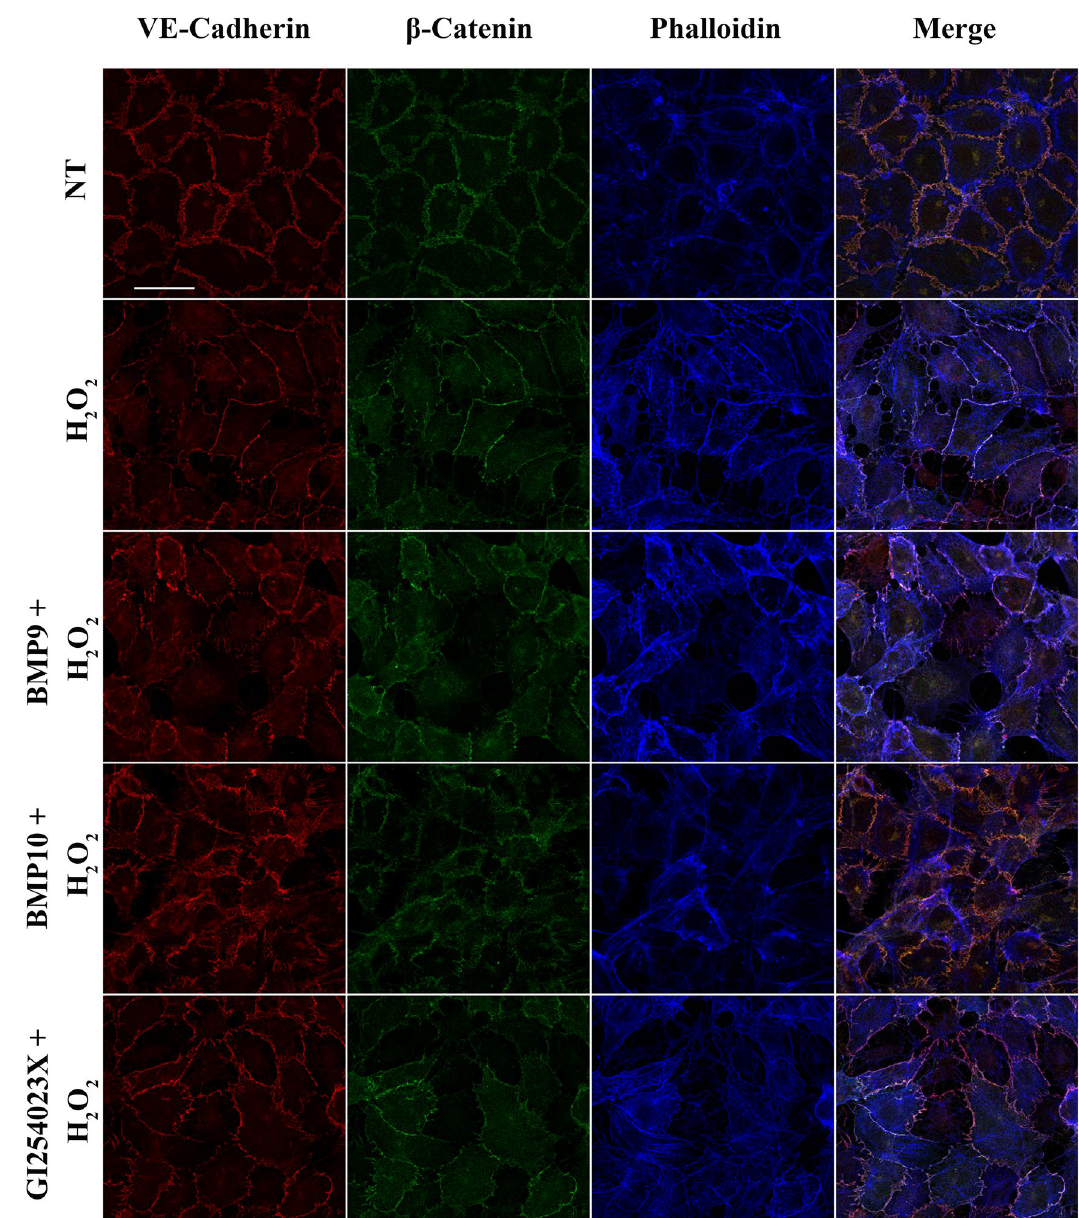
Figure 4. VE-cadherin, β-catenin and F-actin distribution in HUVECs exposed to oxidative stress. HUVECs were pre-treated with BMP9, BMP10 (10 ng/ml) or GI254023X (10 μM) for 24h and then exposed to H 2 O 2 (500 µM) for 6h. HUVECs were stained for VE-Cadherin (red), β-Catenin (green) using specific antibodies. Phalloidin was used to stain F-actin (blue). Scale bar=30